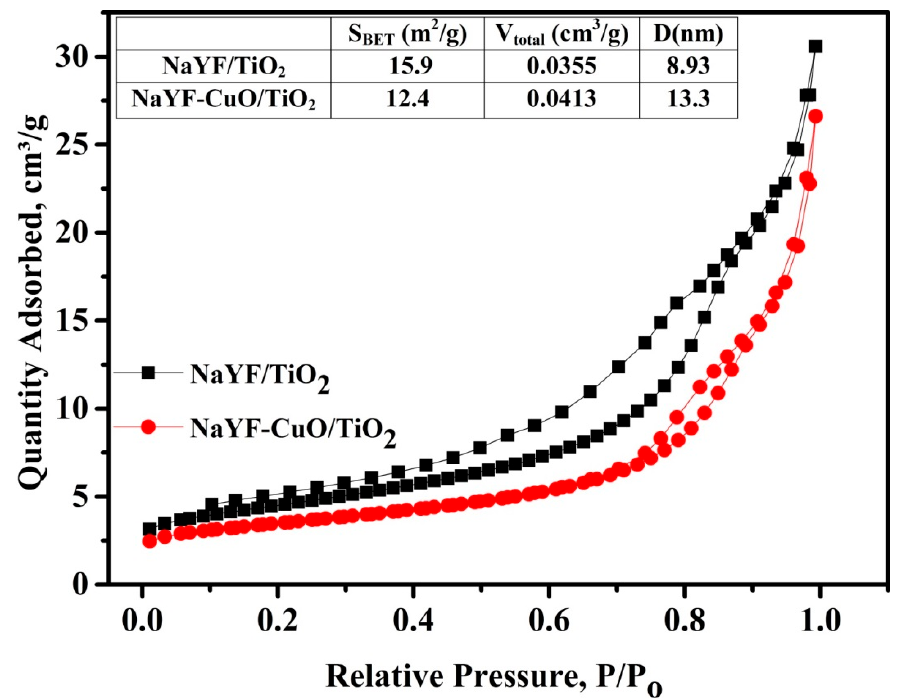
Figure 3. N 2 adsorption-desorption isotherms of NaYF 4 :(Yb,Er)/TiO 2 and NaYF 4 :(Yb,Er)-CuO/TiO 2 . NaYF represents NaYF 4 :(Yb,Er).